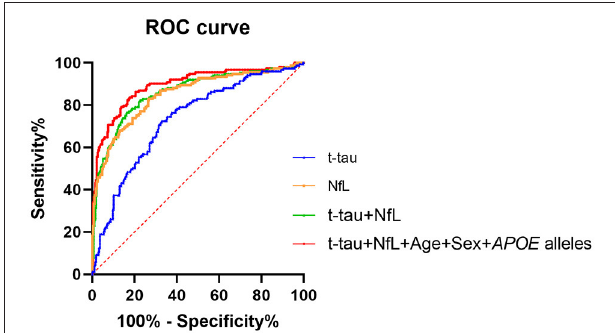
FIGURE 2 | ROC curve analysis of plasma biomarkers for the AD diagnosis. NfL levels in plasma exhibited the best diagnostic efficacy as a single indicator (AUC = 0.85, sensitivity = 73.28%%, specificity = 83.00%). Combined with t-tau and NfL levels in plasma, the diagnostic performance was significantly improved (AUC = 0.86, sensitivity = 83.75%, specificity = 76.47%). The diagnostic model combining plasma t-tau and NfL levels, age, sex, and APOE alleles showed the best performance for the identification of probable AD (AUC = 0.89, sensitivity = 82.31%, specificity = 83.66%). Delong test was performed to compare the difference of different diagnostic models. AUC, area under the curve; ROC, receiver operating characteristic curve; NfL, neurofilament light chain; t-tau, total tau.